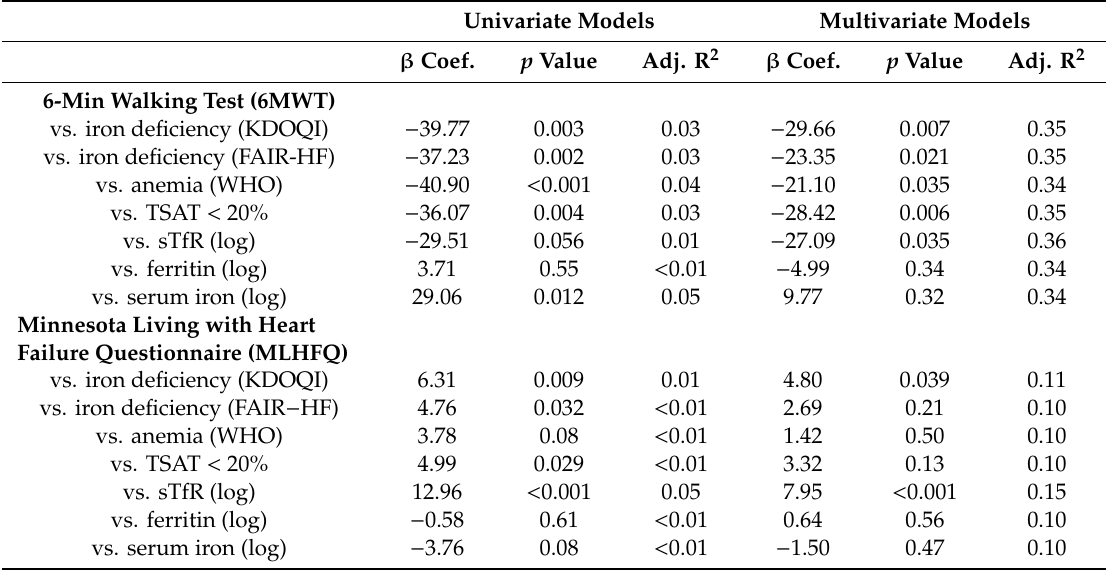
Table 3. Univariate and multivariate linear regression models for 6MWT and